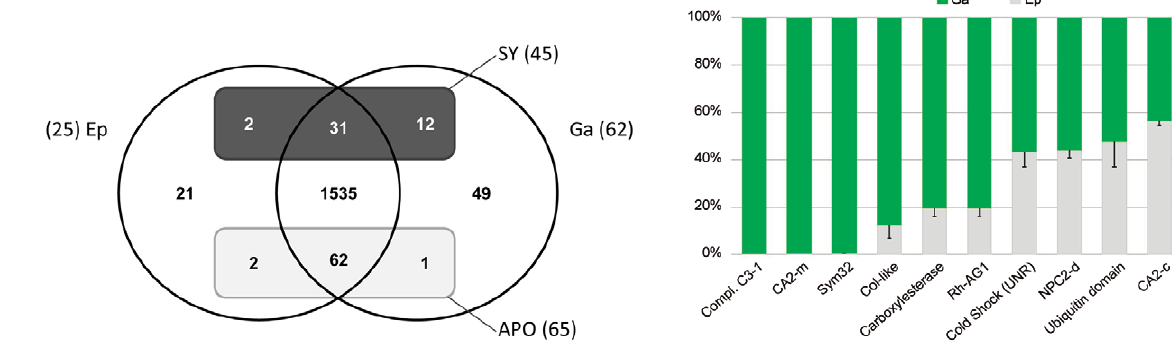
Figure 5. Tissue-specific expression of targeted genes. RT-qPCRs were performed on the epidermal (Ep) and gastrodermal (Ga) total RNA extracts from 3 different sea anemones. The histogram shows the relative Ep (gray) versus Ga (green) expression of the genes listed on the histogram (error bars represent standard error).